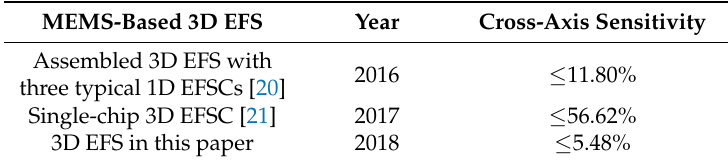
Table 3. Cross-axis sensitivity comparison of the reported MEMS-based 3D EFSs.